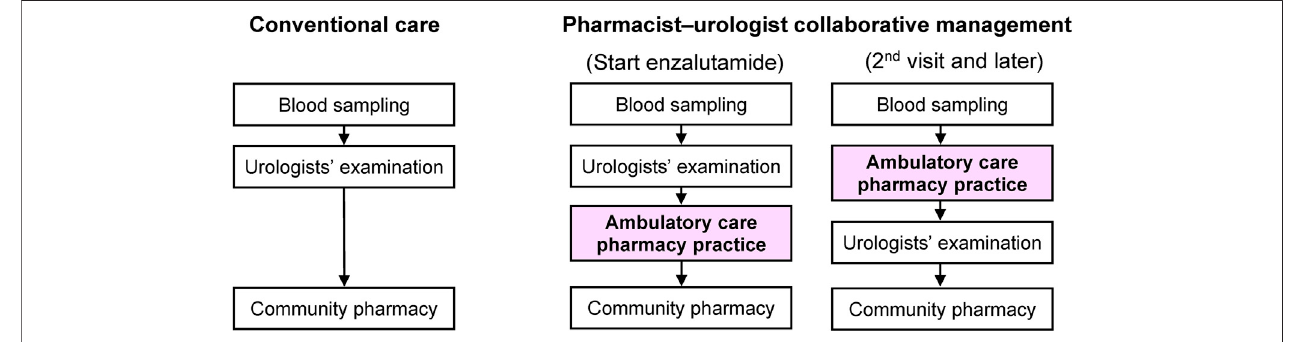
FIGURE 1 | Flowchart of pharmacist-physician collaborative management and conventional care.